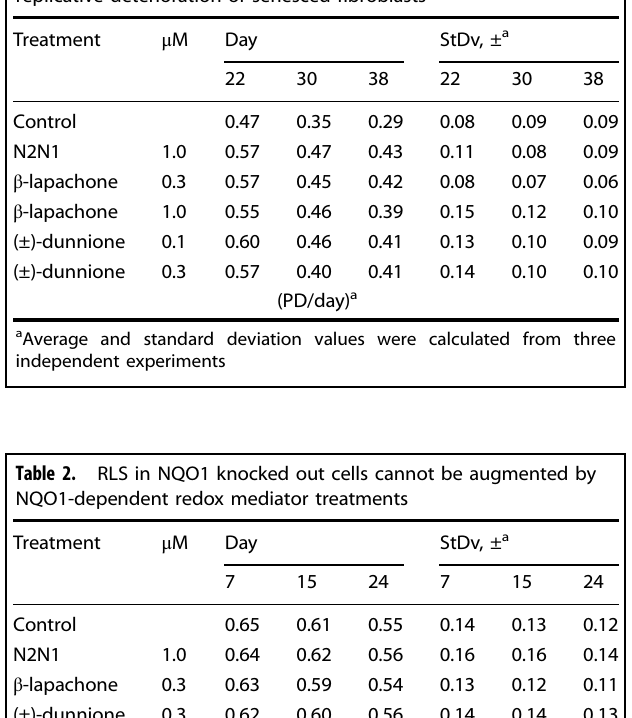
Table 1. The NQO1-dependent redox mediators slow down replicative deterioration of senesced fi broblasts Treatment